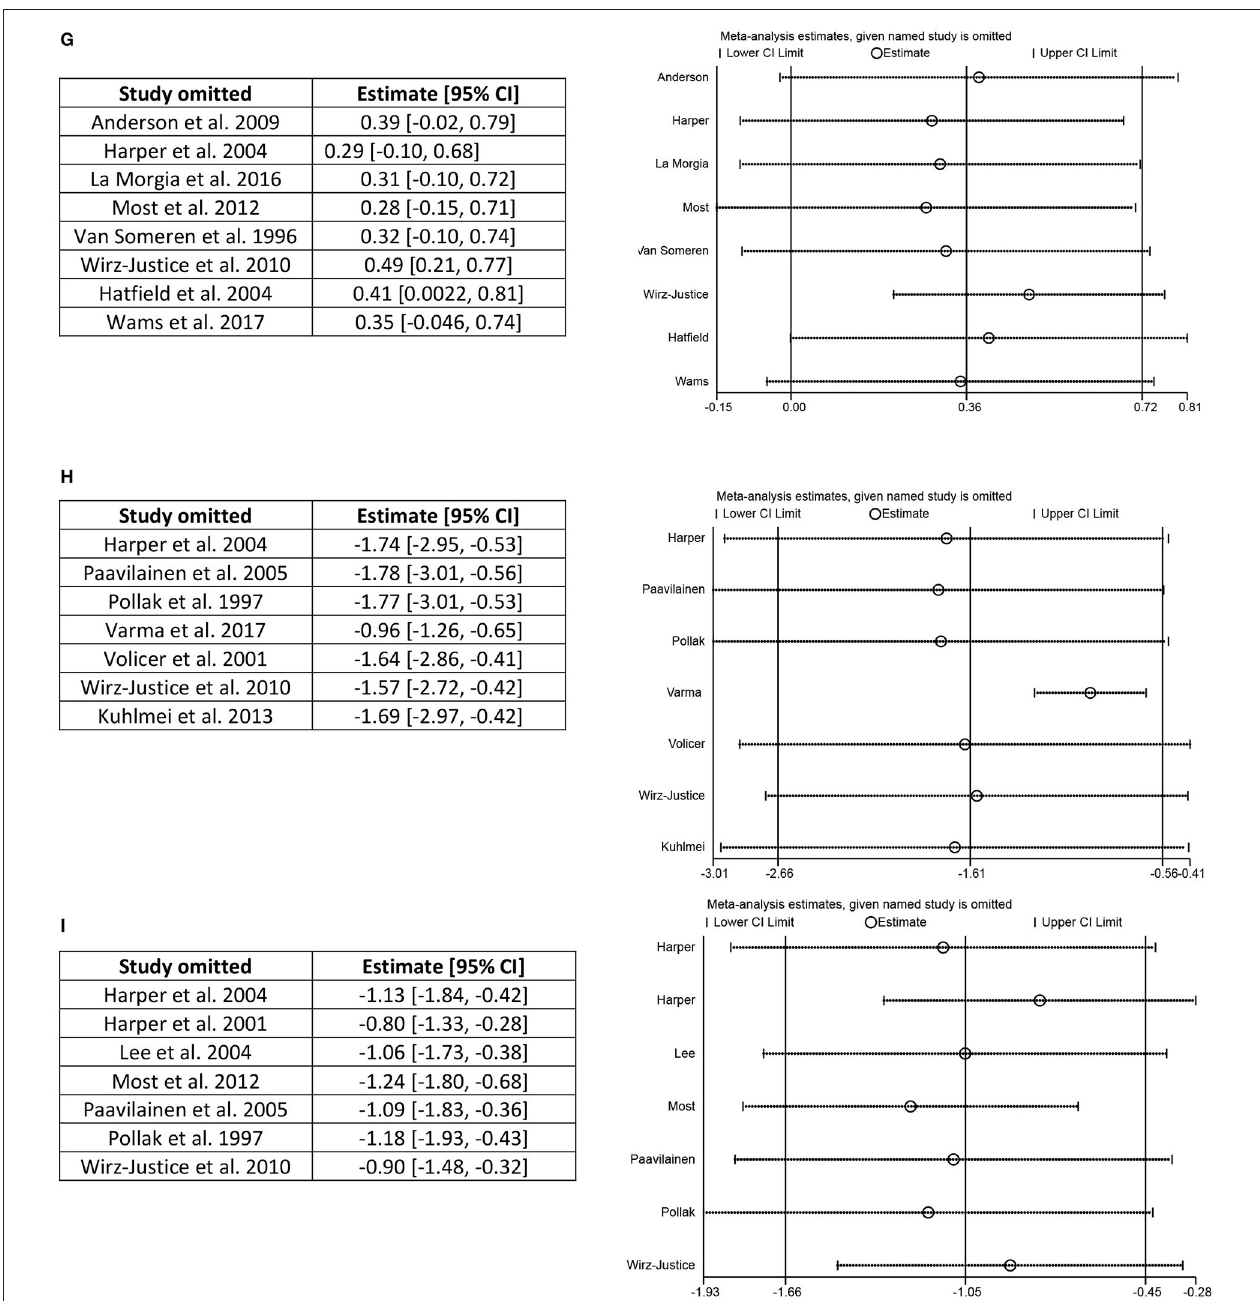
FIGURE 4 | Influence analysis. (A) Interdaily stability, (B) intradaily variability, (C) relative amplitude, (D) activity of most active 10h, (E) total sleep time, (F) sleep efficiency, (G) activity of least active 5h, (H) daytime activity, and (I)